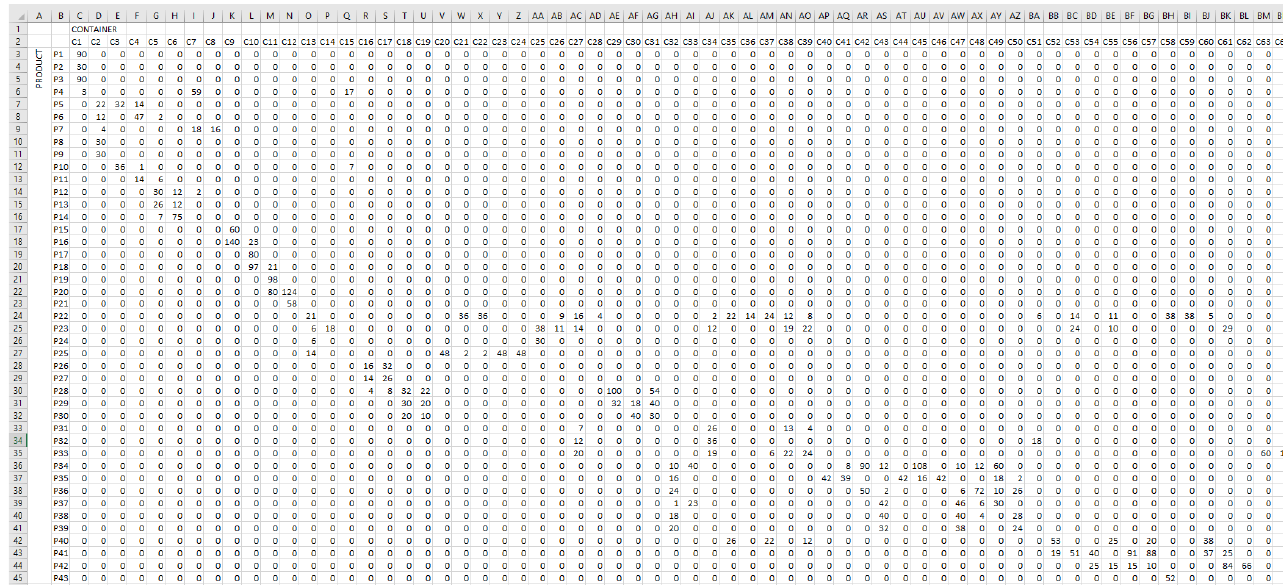
Figure 3. An example of production schedule ( y ) output format in Excel.